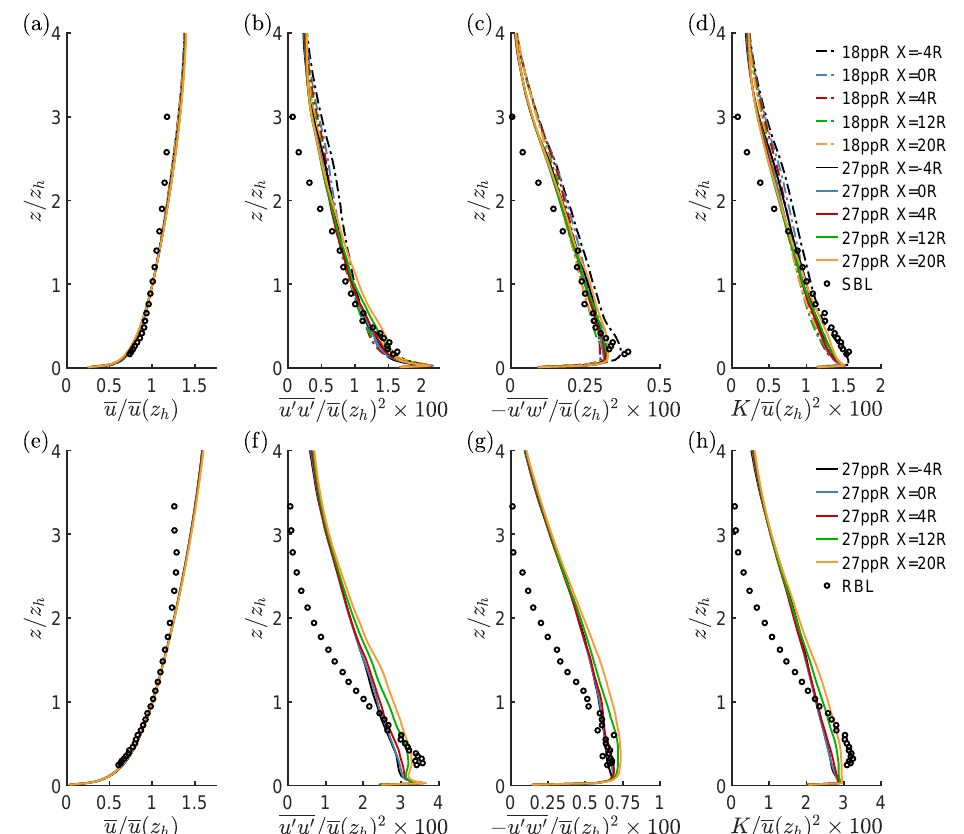
Figure 8. Vertical profiles at selected locations in the wake region of the empty domain for interme- diate roughness ( α = 0.16, top row) and large roughness ( α = 0.32, bottom row): ( a , e ) mean axial velocity u ; ( b , f ) axial intensity u (cid:48) u (cid:48) ; ( c , g ) Reynolds shear stress u (cid:48) w (cid:48) ; ( d , h ) turbulent kinetic energy K ; all normalized with the reference speed u h = u ( x r , z h )